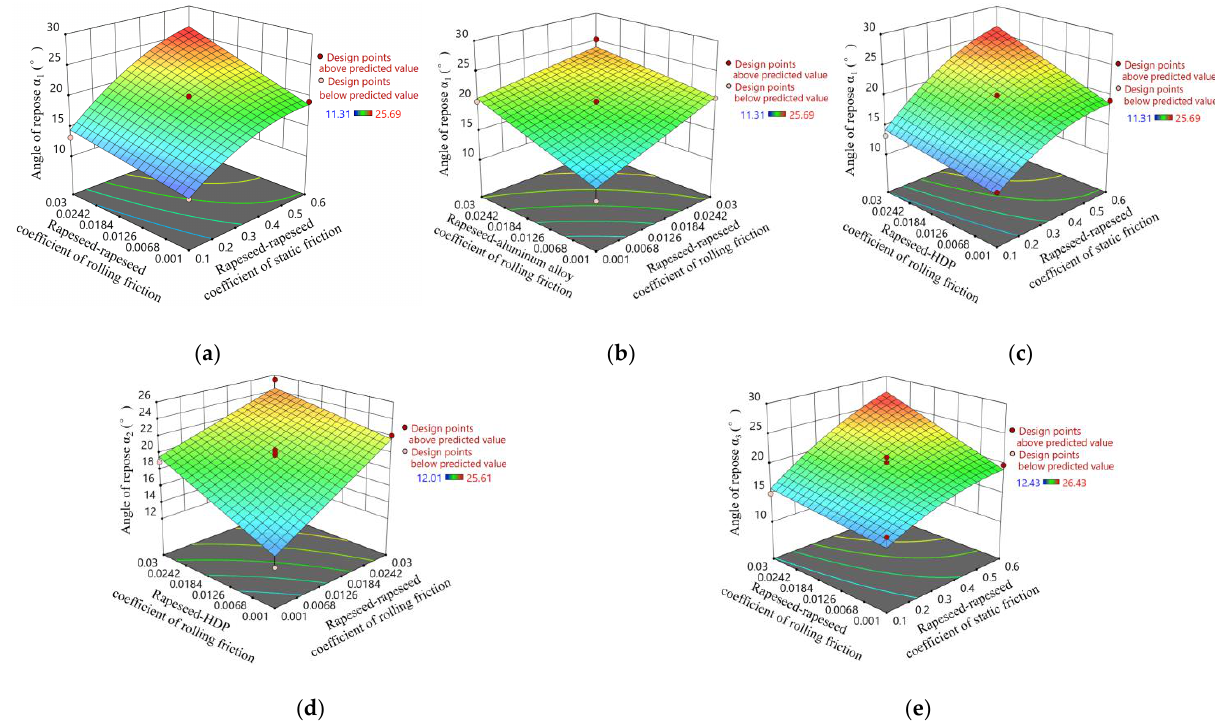
Figure 8. Response surface for interaction factor. ( a ) Interactive effects of rapeseed–rapeseed coefficient of rolling friction